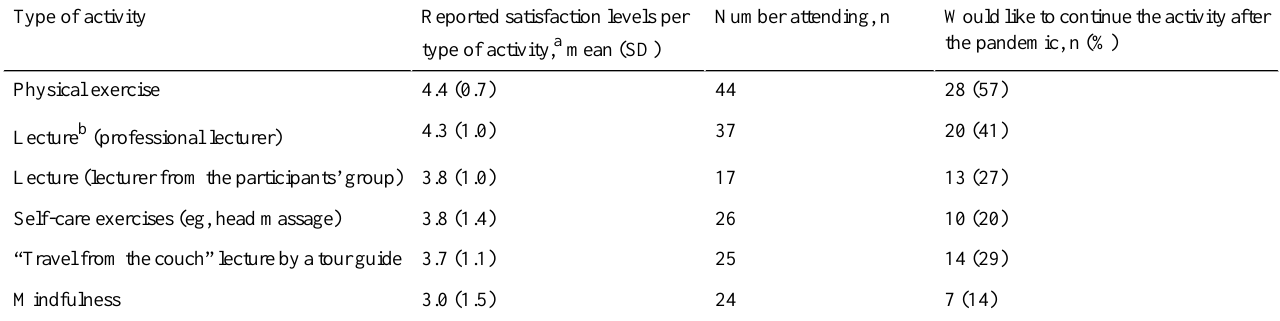
Table 3. Reported levels of satisfaction and desire to continue each type of activity offered by Healthy Aging after the COVID-19 pandemic (n=49). (SD)Type of activity